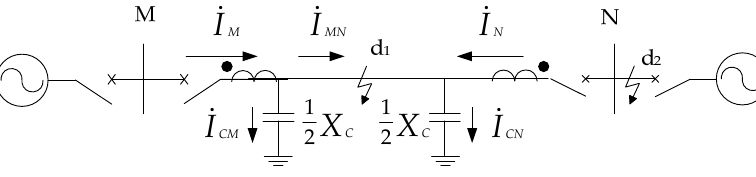
Figure 1. Half-length compensation schematic diagram.